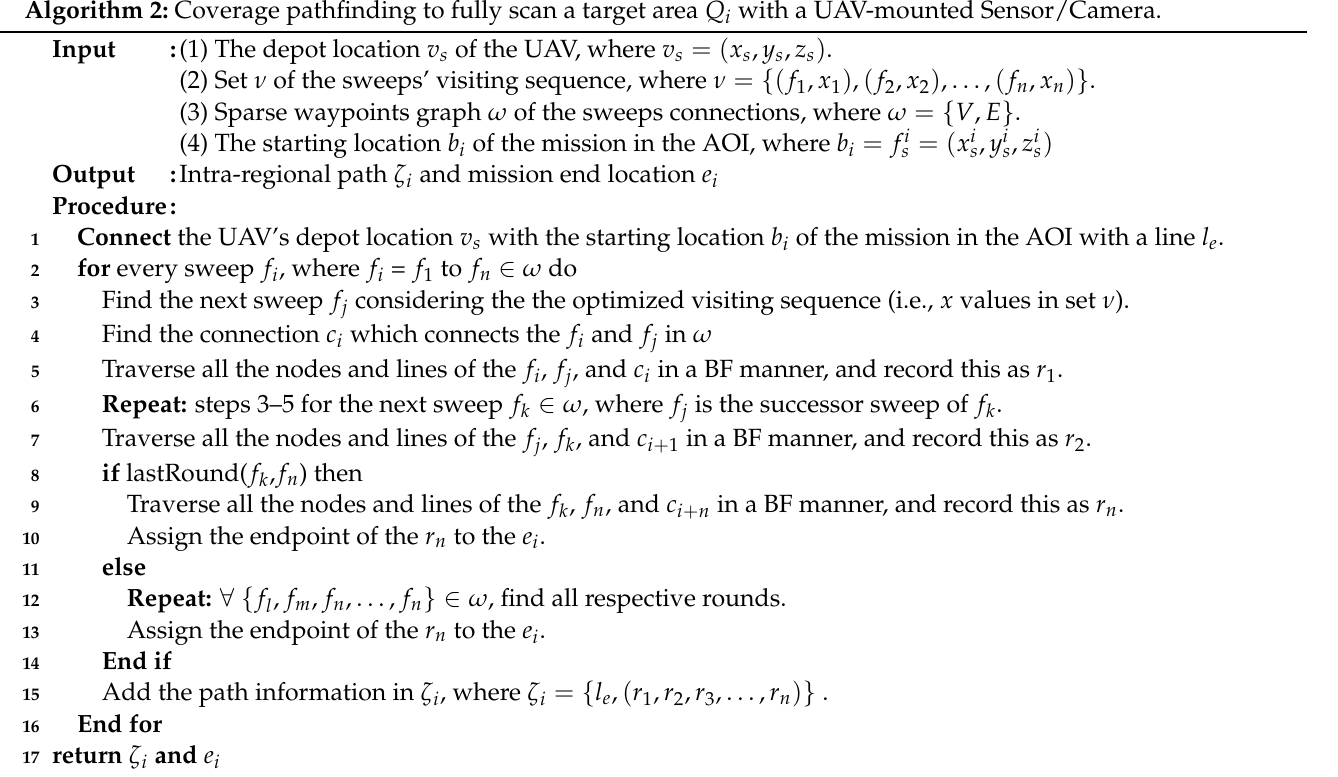
Algorithm 2: Coverage pathfinding to fully scan a target area Q i with a UAV-mounted